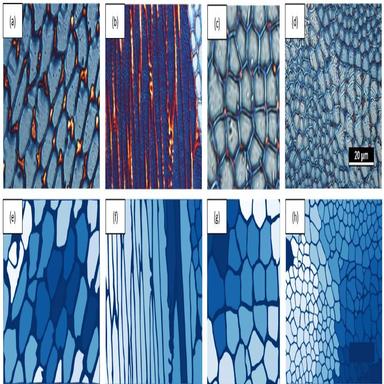
Four representative samples of the twenty-three manually prepared ground truth images using Supervisely labeling tool, (a) to (d) original images, (e) to (h) the corresponding ground truths.